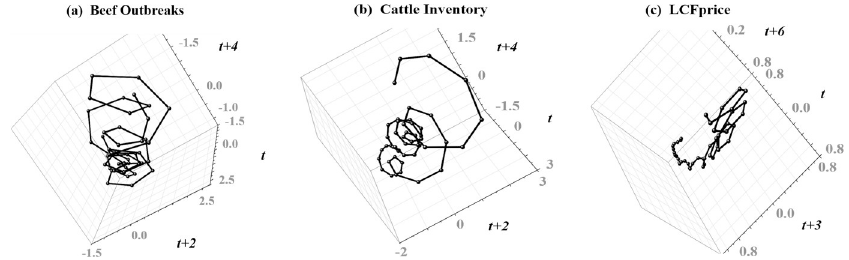
Fig 3. Nonlinear phase space reconstruction with time-delay embedding. Shadow attractors reconstructed from the (a) B-FDO signal (annual foodborne disease outbreaks attributed to beef), (b) the CI signal (cattle inventory), and (c) the LCFprice signal (live cattle futures market prices) with the upward linear trend removed. Each shadow attractor exhibits wide-swinging outer oscillations reflecting multi-decadal nonlinear trend cycles, and tighter interior cycling reflecting higher-frequency oscillations.